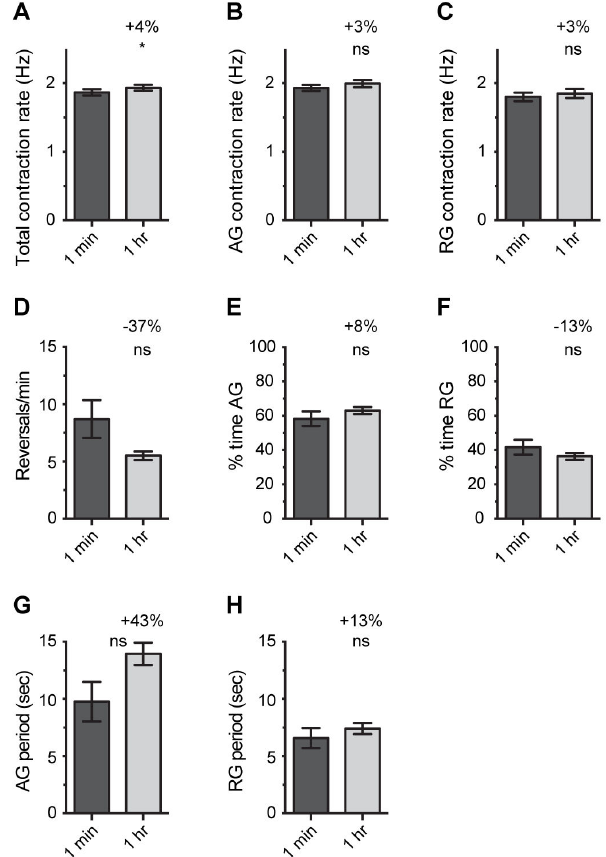
Figure 4. Heart physiology at 1 min and 1 h following FlyNap anesthesia. Mosquitoes were anesthetized by exposure to FlyNap (FN) for 30 sec, and heart recordings were acquired at 1 min and 1 h following FlyNap treatment. The following